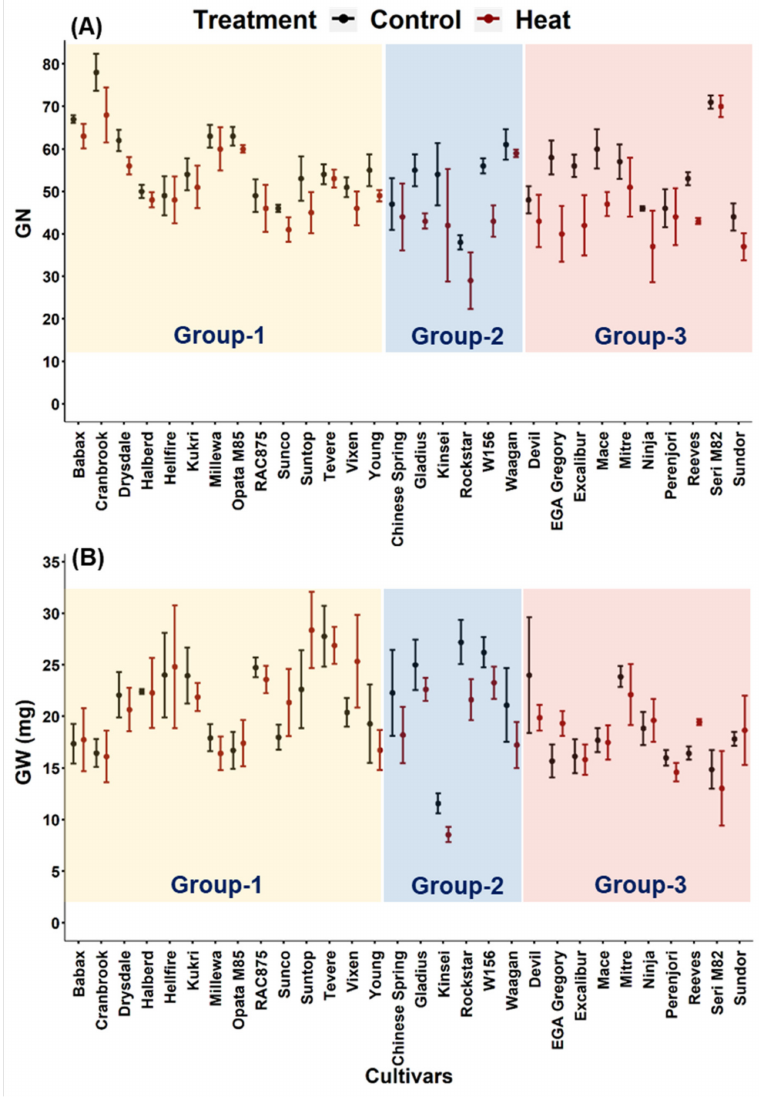
Figure 3. ( A ) Grain number (GN) and ( B ) average individual grain weight (GW) in the main stem spike for wheat cultivars under high temperature (red) and control (black) treatments during meiosis. The ‘tolerant’ cultivars are in pale yellow box (Group 1) and ‘sensitive’ cultivars are in the pale blue (Group 2) and pink (Group 3) boxes. The groupings are based on the principal component analysis in Figure